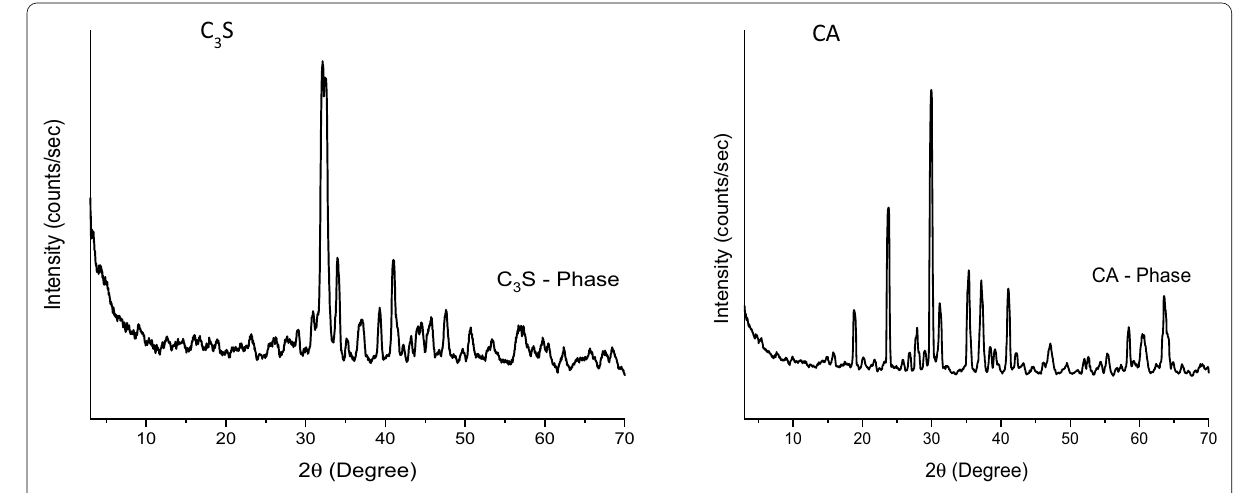
Fig. 1 X-ray diffraction patterns of tri-calcium silicate (C 3 S) and calcium aluminate (CA) phases